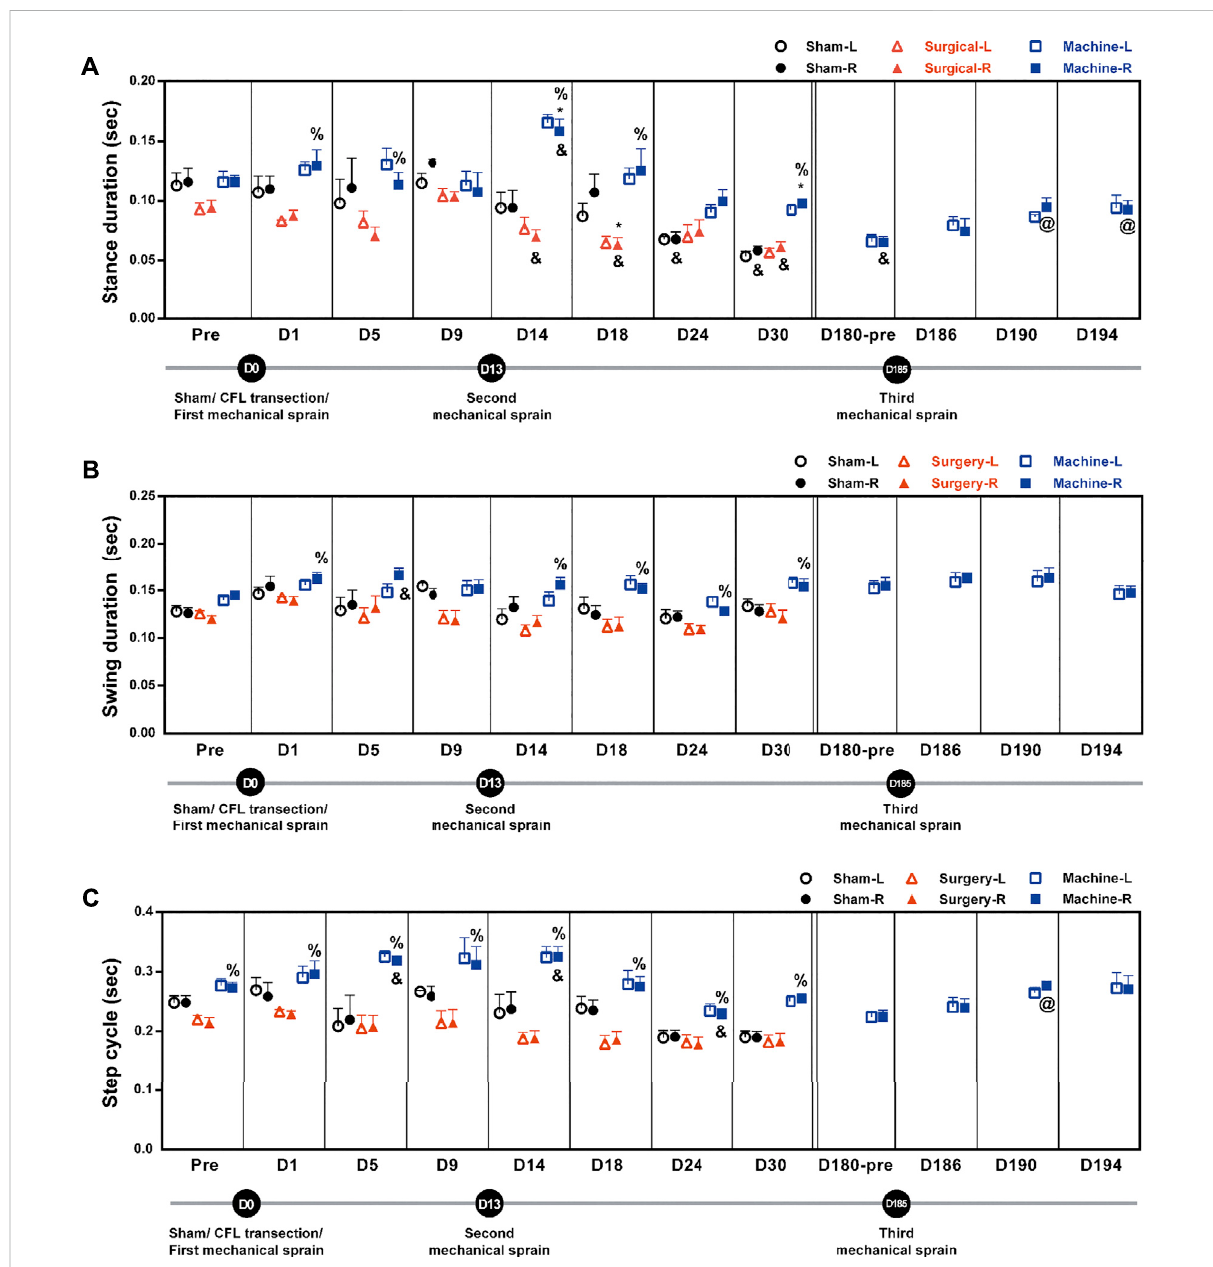
FIGURE 5 Mechanicalanklesprainsinducesgaitabnormalitiesinstanceduration,swingduration,andstepcycle.Footprintwasmeasuredandanalyzedon days indicated on the graphs after sham operation, CFL transection, and three mechanical ankle sprains to obtain gait parameters including stance duration (A) ,swing duration (B) andstep cycle (C) .Values aremean±SEM, n =4.Thestatistical signi fi cancewasanalyzedusingunpaired t test(*and %) or paired t test (@ and & ). * p < 0.05 compared with the corresponding right foot (R) of the sham operation group; % p < 0.05 compared with the corresponding right injured foot of the surgical transection group; & p < 0.05 compared with the corresponding pretreatment (pre) baseline; @ p < 0.05 compared with the pretreatment baseline of the third mechanical ankle sprain on the 180th day